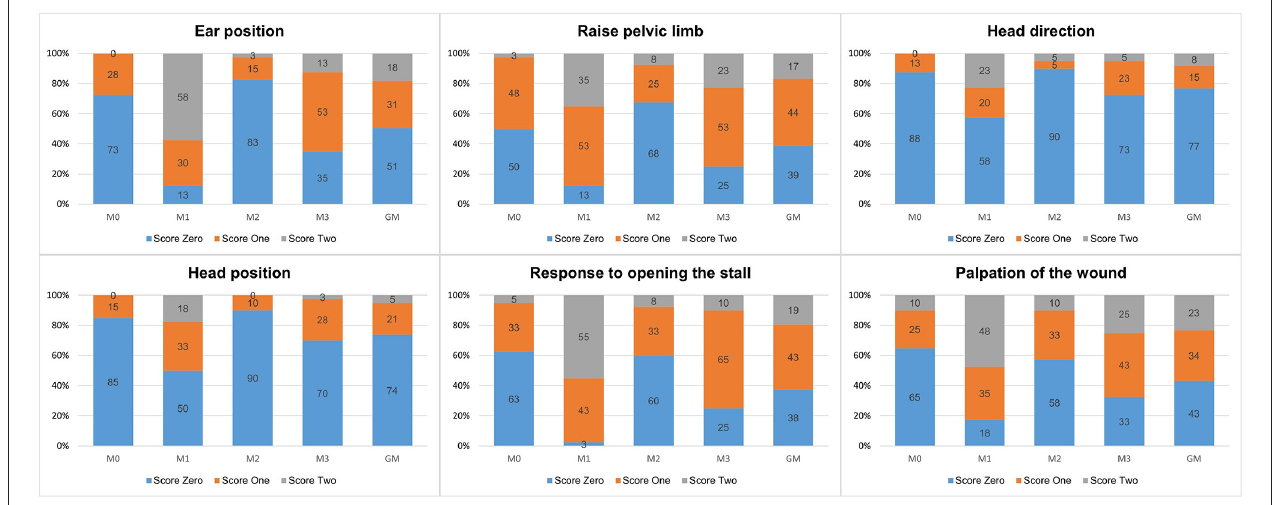
FIGURE 1 | Frequency (%) of pain scores, for the DOPS to evaluate acute pain in donkeys.